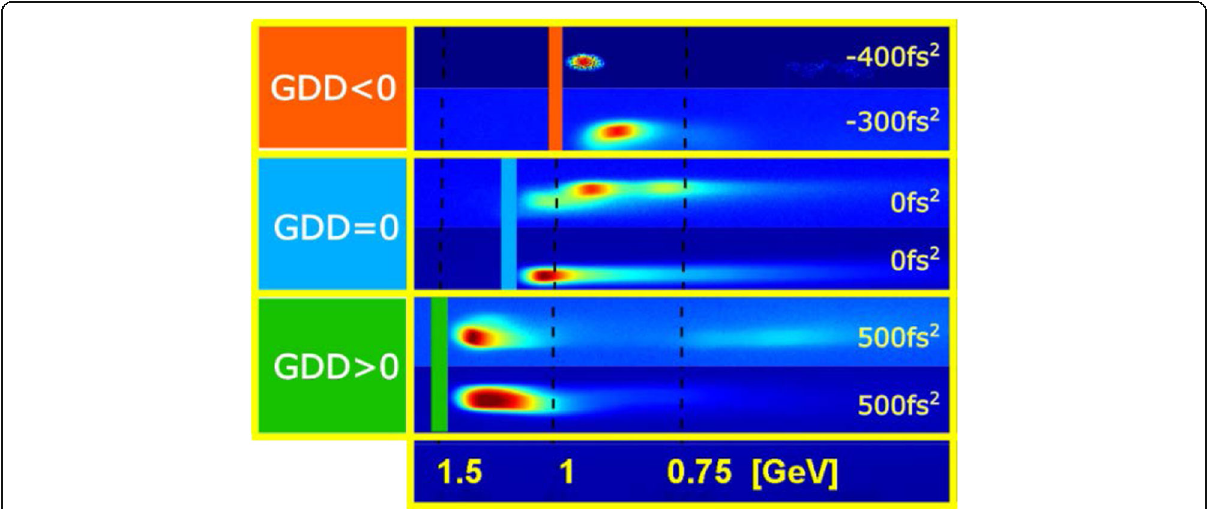
Fig. 16 Effects of group-delay dispersion on the energy of electron beams in experiment. Spectra of electron beams are shown for GDD < 0 ( − 400 fs 2 , − 300 fs 2 ), GDD = 0 (0 fs 2 , 0 fs 2 ) and for GDD > 0 (500 fs 2 , 500 fs 2